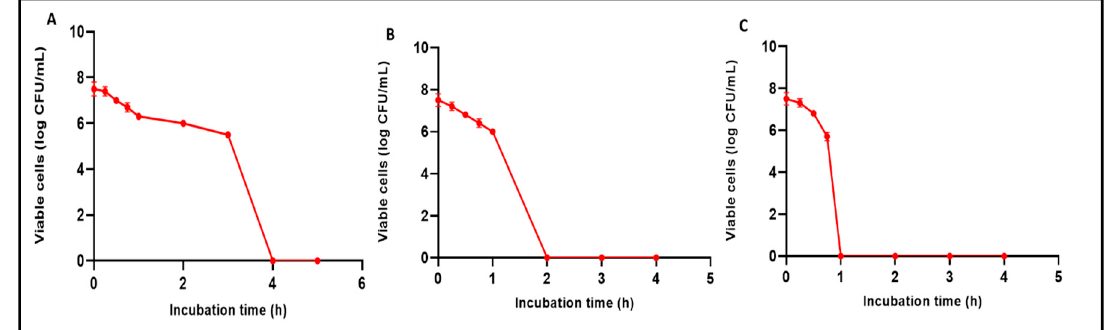
Figure 8. Charts representing the decrease in the number of CFU/mL of C. albicans isolates after incubation with AgNPs: ( A ) with concentrations of 2× MIC for four hours, ( B ) 4× MIC for two hours, and ( C ) 8× MIC for one hour. Table 2. Impact of AgNPs on biofilm formation by C. albicans isolates.